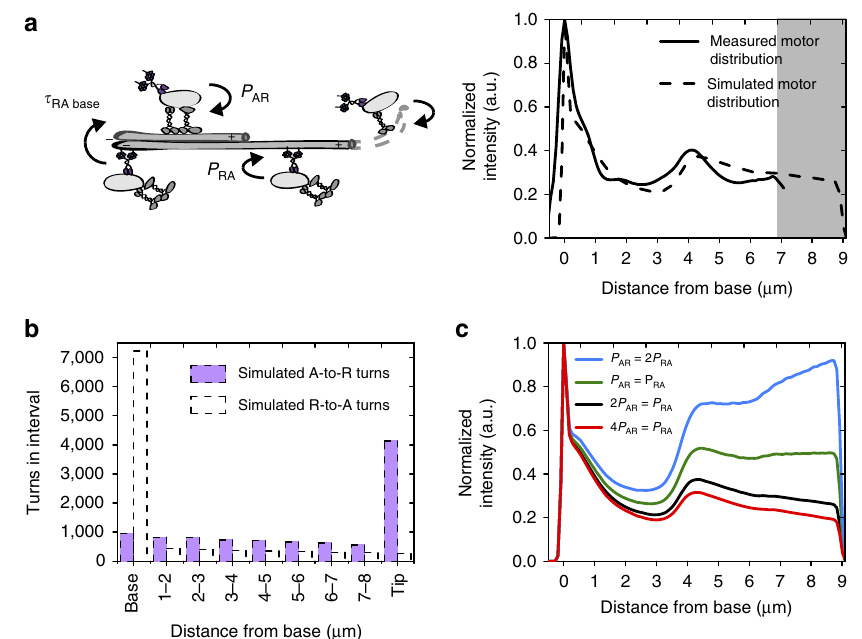
Figure 4 | Stochastic modelling connects dynamics of individual IFTdyneins to ensemble behaviour. ( a , left) Cartoon highlighting stochastic simulations of single IFT dyneins walking and turning around in the cilium. The input parameters of the simulations are indicated. The probability densities of an IFT dynein A-to-R turn ( P AR , 0.14 m m (cid:2) 1 ) and an R-to-A turn ( P RA , 0.07 m m (cid:2) 1 ), were obtained experimentally. Pausing time for A-to-R turns ( t AR , no pause) and R-to-A turns at the base ( t RA , 500ms) were estimated. ( a , right) Measured (black line) and simulated (dotted line) IFTdynein steady-state distribution in the cilium. In the simulations, we assumed that all IFT-dynein motors in the tip region (shown in grey; not in focus in experimental measurements) turn. ( b ) Simulated numbers and positions of A-to-R (dotted, black) and R-to-A (dotted, purple) turns. ( c ) The effect of P AR and P RA on IFT-dynein motor distribution in stochastic simulations. Motor distribution in black was obtained using probability parameters calculated from the single-molecule experiments ( P AR ¼ 0.14 m m (cid:2) 1 , P RA ¼ 0.07 m m (cid:2) 1 ) and most closely corresponds to the IFT-dynein distribution from ensemble measurements (same as solid line in ( a )). Green ( P AR ¼ 0.14 m m (cid:2) 1 , P RA ¼ 0.14 m m (cid:2) 1 ), blue ( P AR ¼ 0.07 m m (cid:2) 1 , P RA ¼ 0.14 m m (cid:2) 1 ) and red ( P AR ¼ 0.28 m m (cid:2) 1 , P RA ¼ 0.07 m m (cid:2) 1 ) are simulated distributions of altered turnaround probabilities. To account for the overlap of two phasmid cilia in the distal segment, intensities and histograms were multiplied by 2 (cid:2) (1/(e ( x (cid:2) 3,500)/200 þ 1)). See also Supplementary Fig.